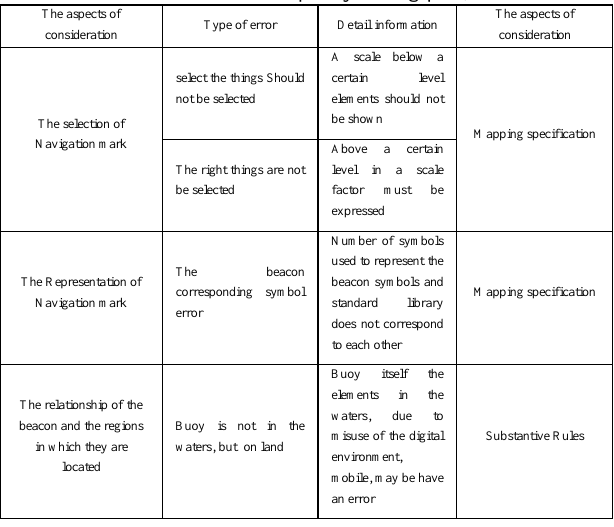
table3-1 Beacon quality testing(part) The aspects